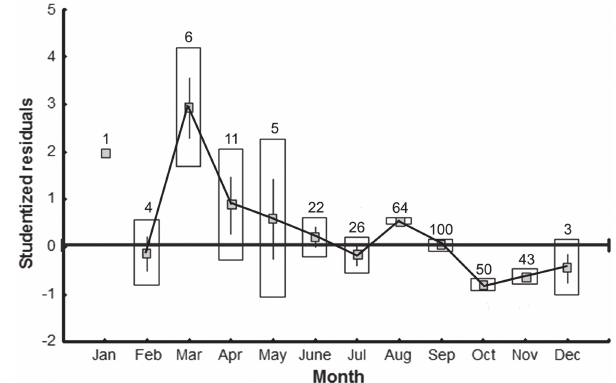
Fig. 4. Residual analysis as an index of condition factor for males, females and unsexed individuals of Prochilodus nigricans from the Aguarico River during 1999 (see Fechhelm et al ., 1995). Shown are the monthly mean (shaded rectangles), ± standard error (vertical lines) and ± 95% confidence interval (open rectangles); sample sizes are above bars. Of a total of 335 stomach samples, 214 (64%) were empty. The percentage of individuals with empty stomachs fluctuated from month to month, yet a seasonal trend was not evident (Fig. 5). Two periods with higher percentages of empty stomachs (April and October) coincided with the spawning and upstream migrations, respectively. The high percentage of empty stomachs in July may be related to relocation (lateral)